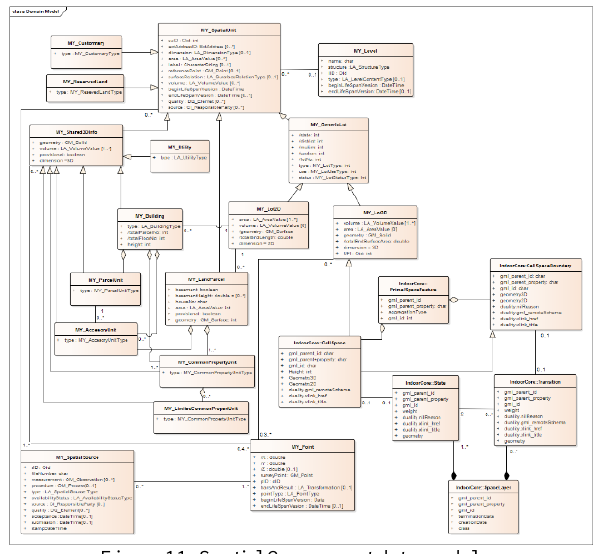
Figure 11. Spatial Component data model